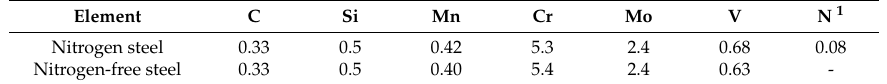
Table 1. Chemical compositions of tested steel (wt %).